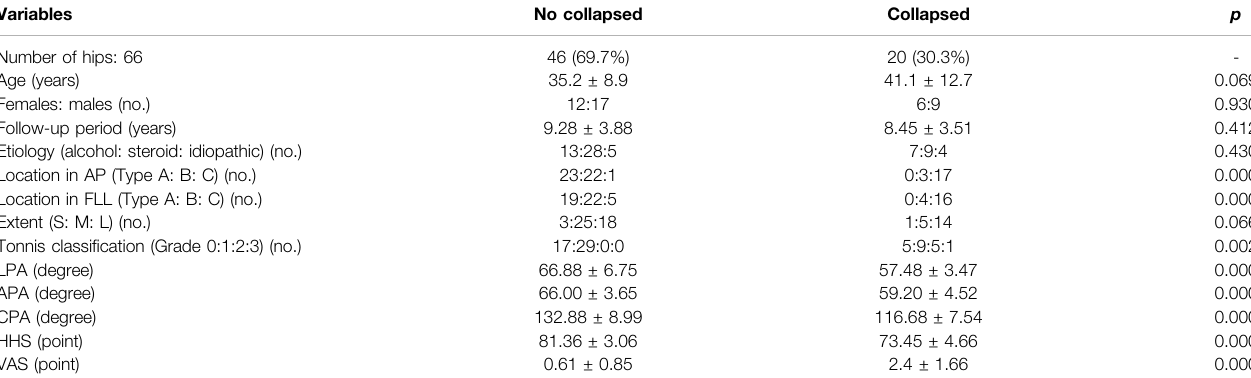
TABLE 2 | Relationship between various parameters and fi nal state of femoral head in ARCO stage II ONFH patients. Variables No collapsed Collapsed p Number of hips: 66